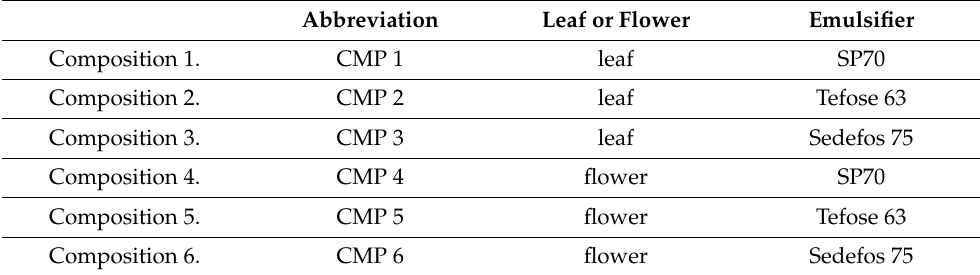
Table 6. Composition of the six ointment formulations.